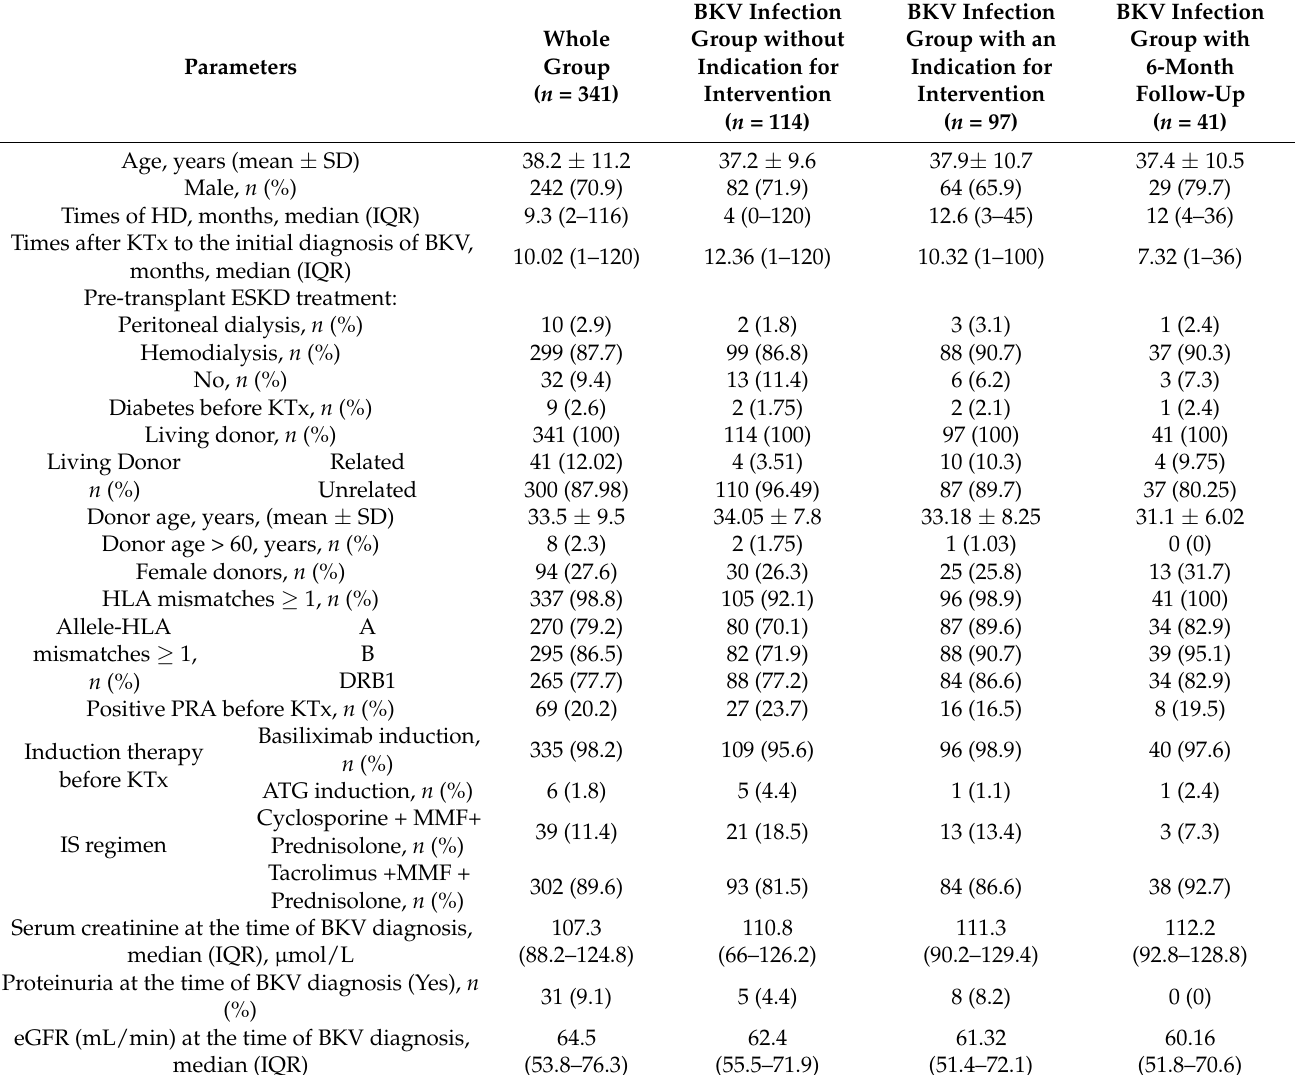
Table 2. Demographic, clinical, and transplant-related data at the time of BKV or BKVN